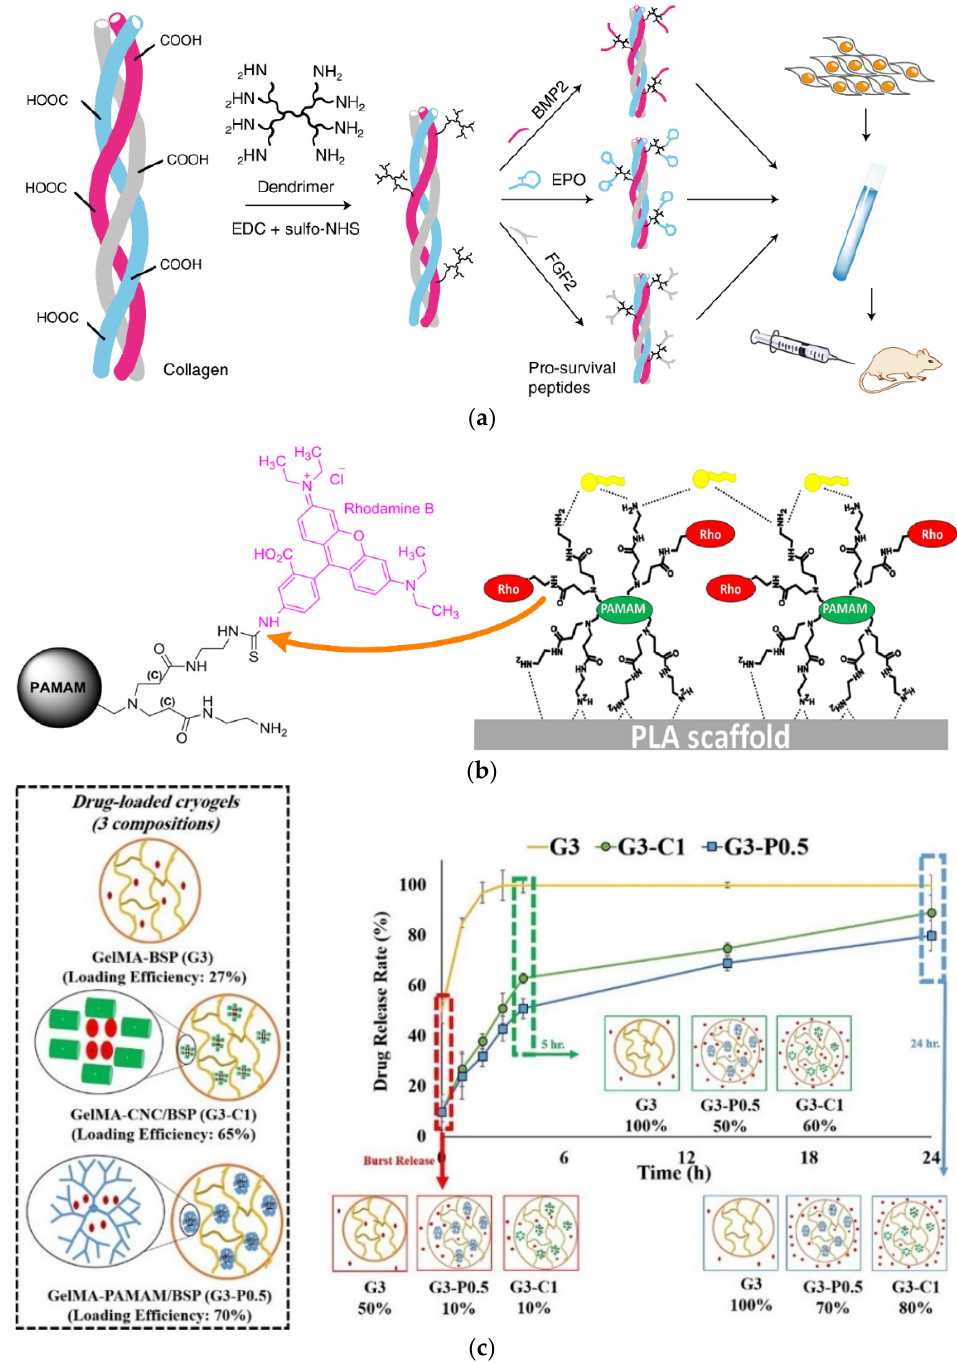
Figure 6. ( a ) Schematic depiction of the method of collagen-G1 PAMAM-peptide synthesis. Repro- duced with permission from [131]. Copyright: The Author(s); ( b ) Rhodamine-PAMAM bioconju- gate and schematic representation of the transfection process by premir-503 loaded dendrimers lay- ered on the PLA surface. Adapted under permission from [135]. ( c ) Betamethasone sodium phos- phate (BSP) loading efficiency to scaffolds of 3 different compositions: gelatin methacrylate (GelMA); GelMA and cellulose nanocrystal carrier (CNC); GelMA and PAMAM; together with the corresponding release profiles. Under permission from [136] Copyright: Elsevier